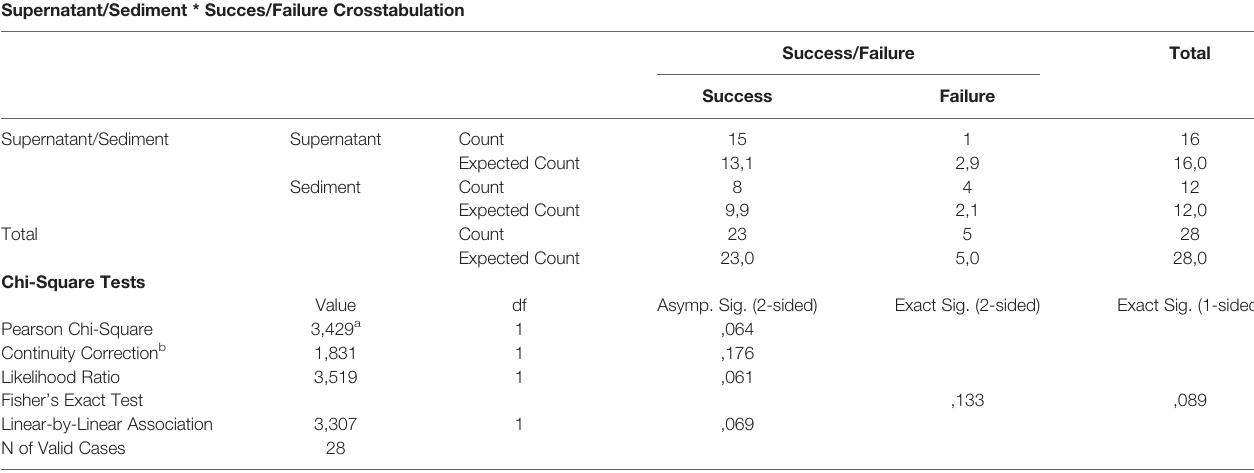
TABLE 3 | Comparison of ef fi cacy of supernatant and sediment capsules. Supernatant/Sediment * Succes/Failure